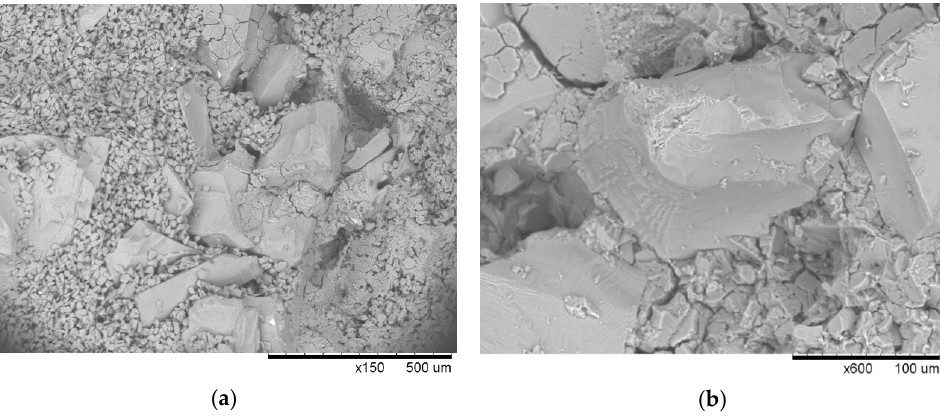
Figure 22. SEM morphology of PW3 sample cross section: ( a ) ×150; ( b ) ×600.